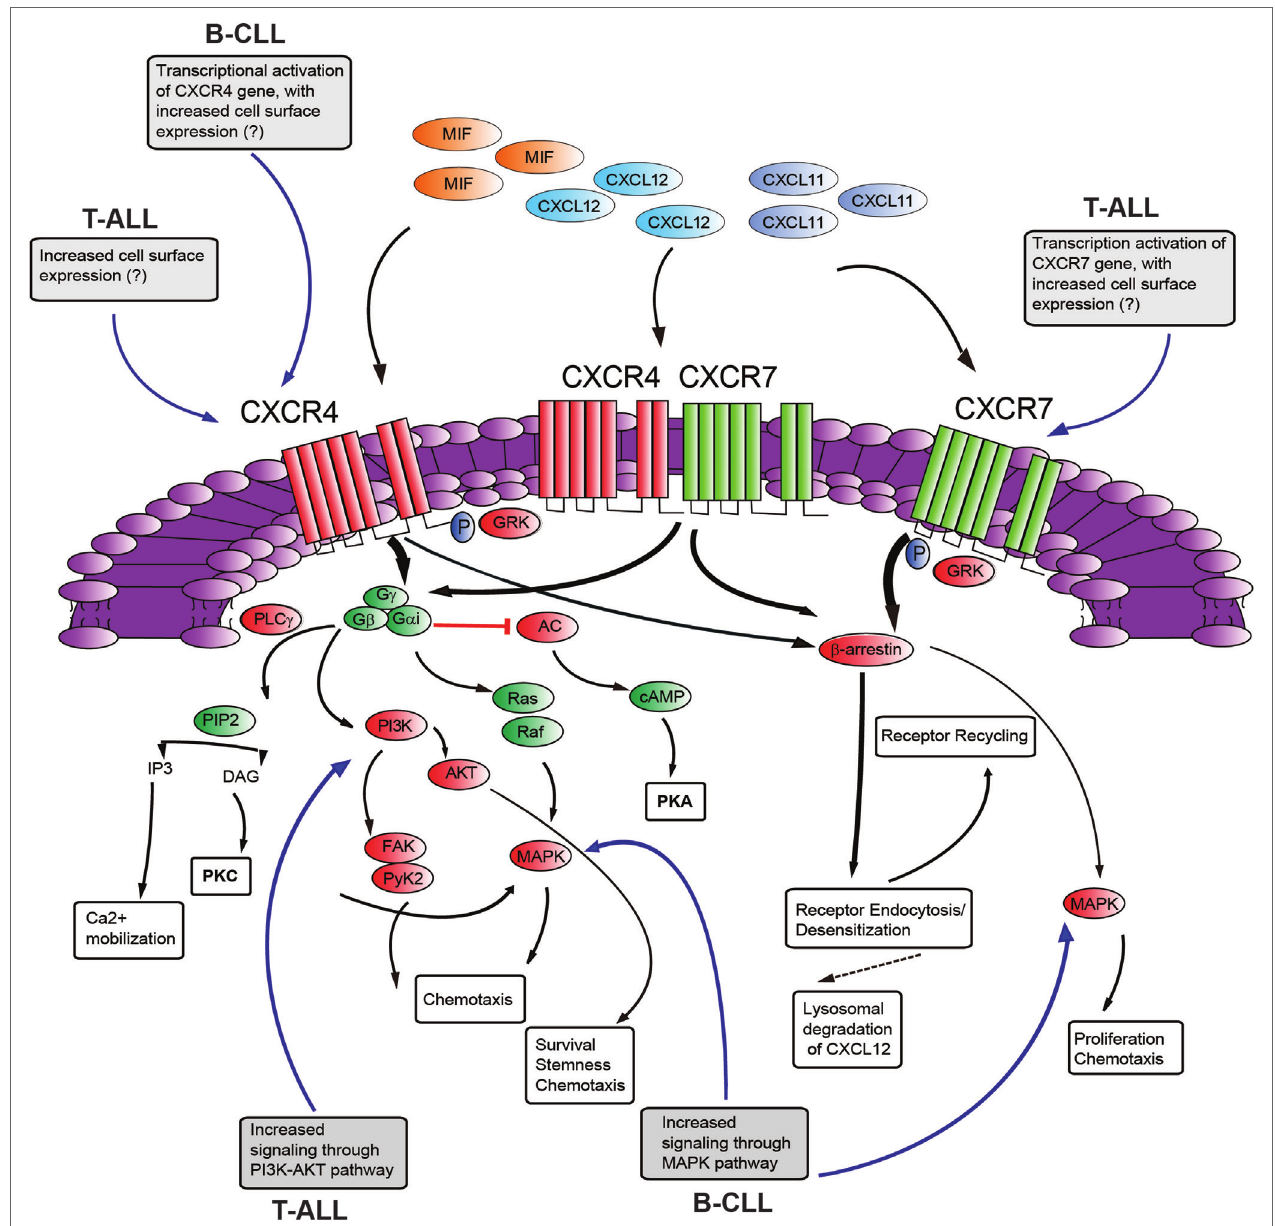
FiGURe 2 | Schematic diagram of putative CXCR4–CXCR7 crosstalk affecting signaling pathways. The influence of NOTCH signaling on the main aspects of this signaling axis is shown in gray boxes [differences between T-cell acute lymphoblastic leukemia (T-ALL) and B-cell chronic lymphocytic leukemia (B-CLL) is presented]. CXCL12 employs two distinct receptors, CXCR4 and CXCR7 which can form homodimers or heterodimers. Additionally, CXCR4 and CXCR7 can act as receptors for macrophage migration inhibitory factor (MIF), while CXCR7 can also bind to CXCL11. Commonly, stimulation of CXCR4 leads to G-protein-coupled chemokine receptors (GPCR) signaling through phosphoinositide-3 kinase (PI3K)/AKT, PLC/IP3, MAPK pathways, and mobilization of Ca2 + from intracellular sources. CXCR4/CXCR7 heterodimerization attenuates GPCR signaling, promoting β -arrestin mediated signaling. Activation of CXCR7 triggers β -arrestin mediated signaling. Internalization of the receptors CXCR4 and CXCR7, and subsequent recycling to the cell surface, is also mediated by β -arrestin. Binding of CXCL12 to CXCR7 promotes internalization and scavenging (lysosomal degradation) of CXCL12. AC, adenylyl cyclase; cAMP, cyclic adenosyl monophosphate; PKA, protein kinase A; PLC, phospholipase C; GRK, GPCR kinase; PI3K, phosphatidylinositide 3-kinase; G α /G β /G γ , heterotrimeric G-protein consisting of subunits α , β , and γ ; PIP2, phosphatidylinositol 4,5-bisphosphate; IP3, inositol 1,4,5-bisphosphate; AKT, protein kinase B; MAPK, mitogen-activated protein kinase; FAK, focal